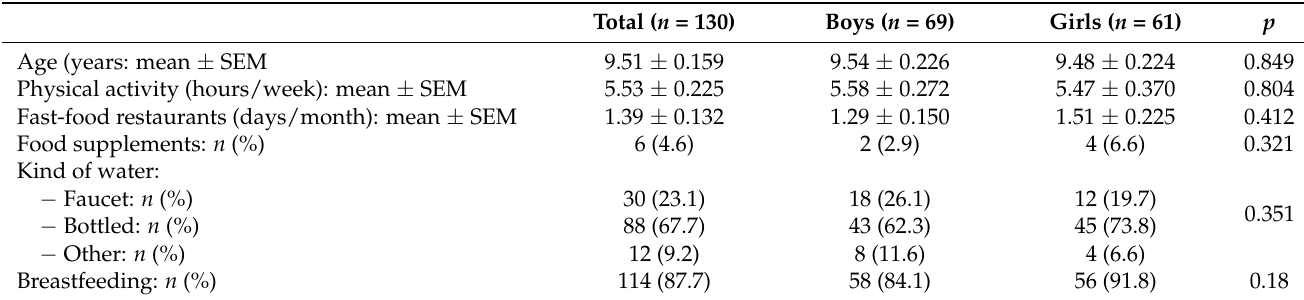
Table 1. Demographic, lifestyle, and food allergies or intolerances among studied children.